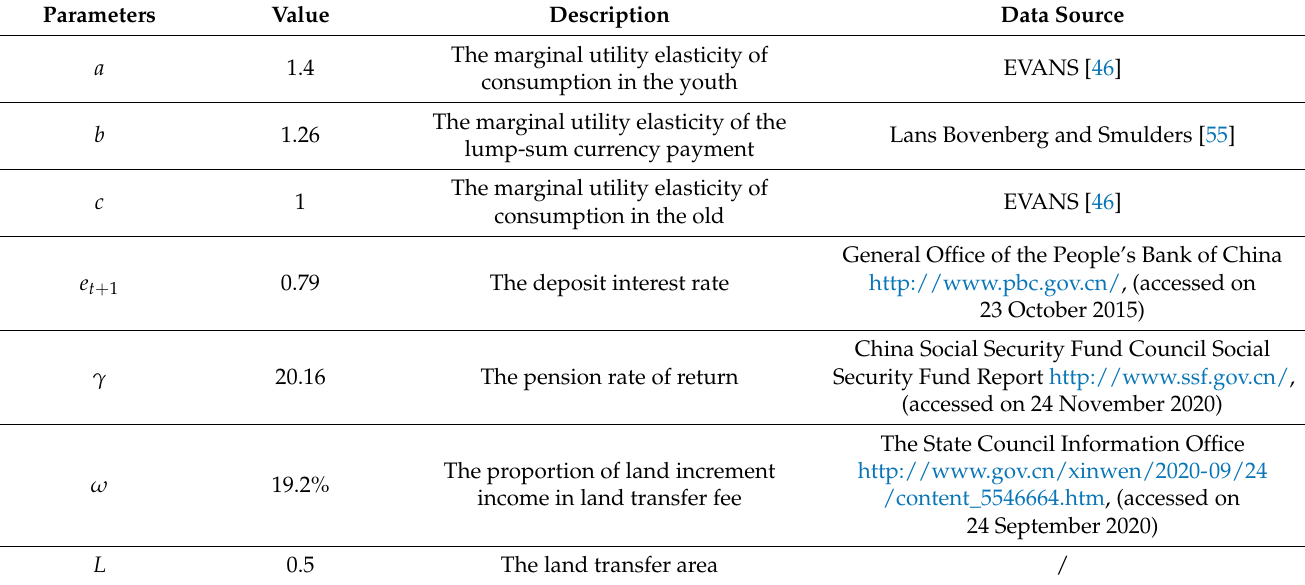
Table 3. Calibration of